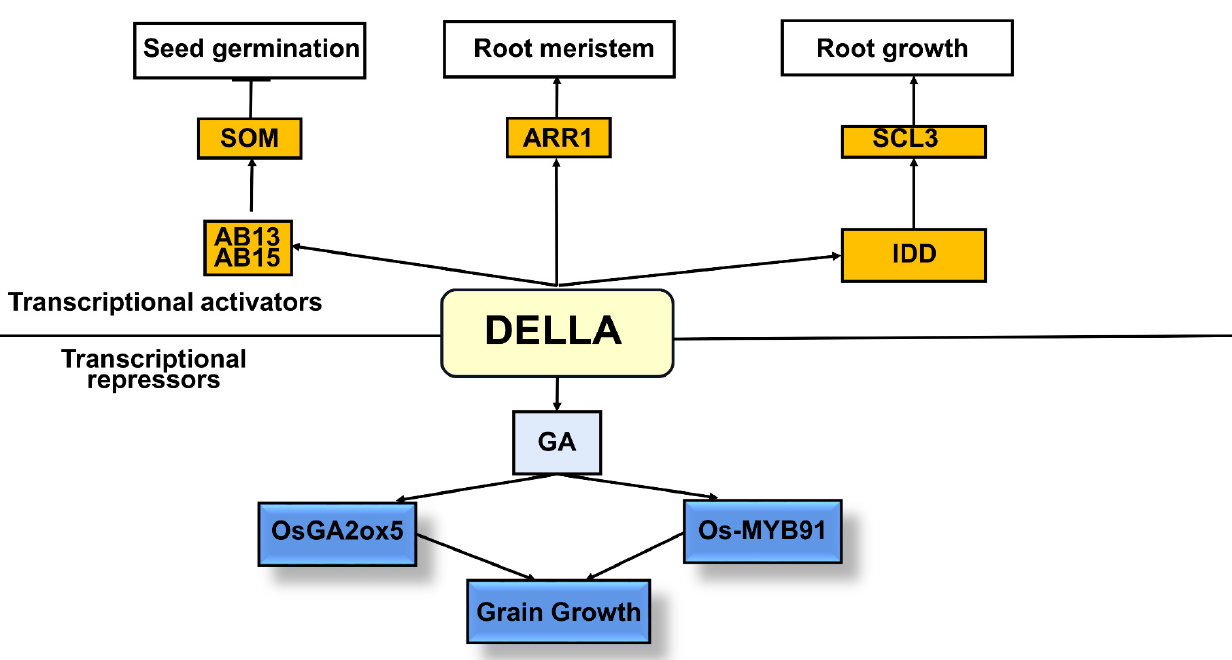
Figure 3. Molecular regulation mechanism of gibberellins in rice under salt stress.